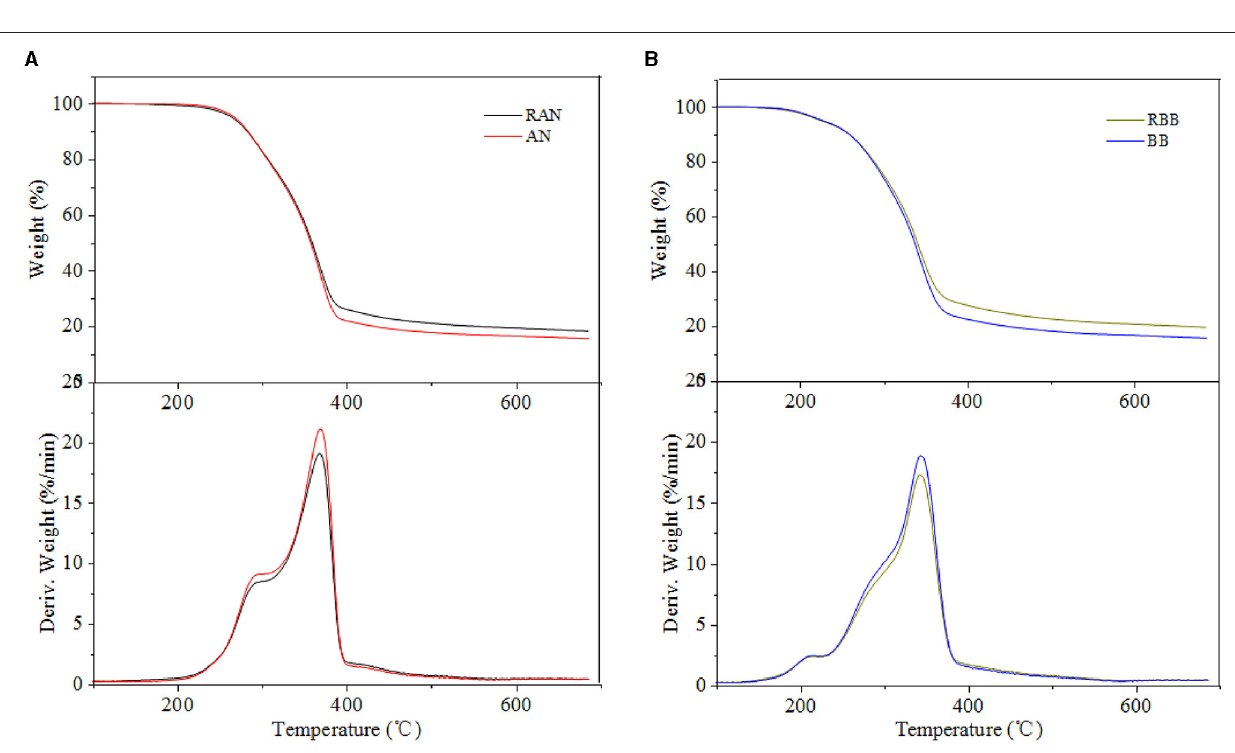
FIGURE 2 | (A,B) TG and DTG curves of raw material and acid-washed